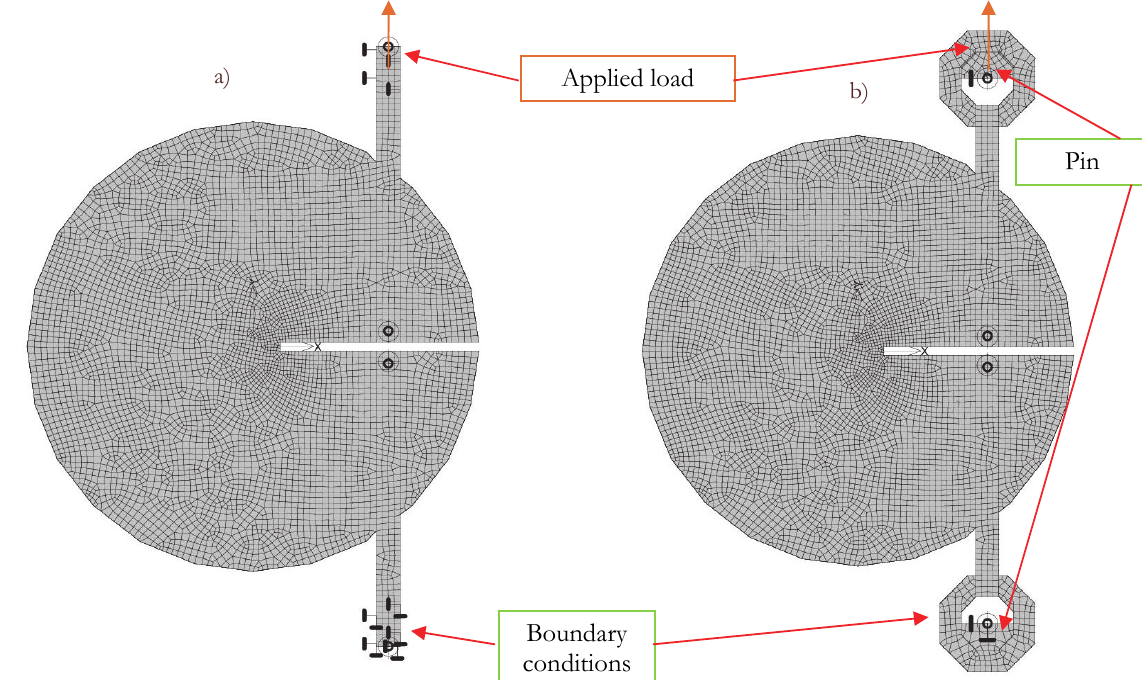
Figure 4: Numerical models of the modified compact tension test with boundary conditions: a) current grips; b) with eye nuts.